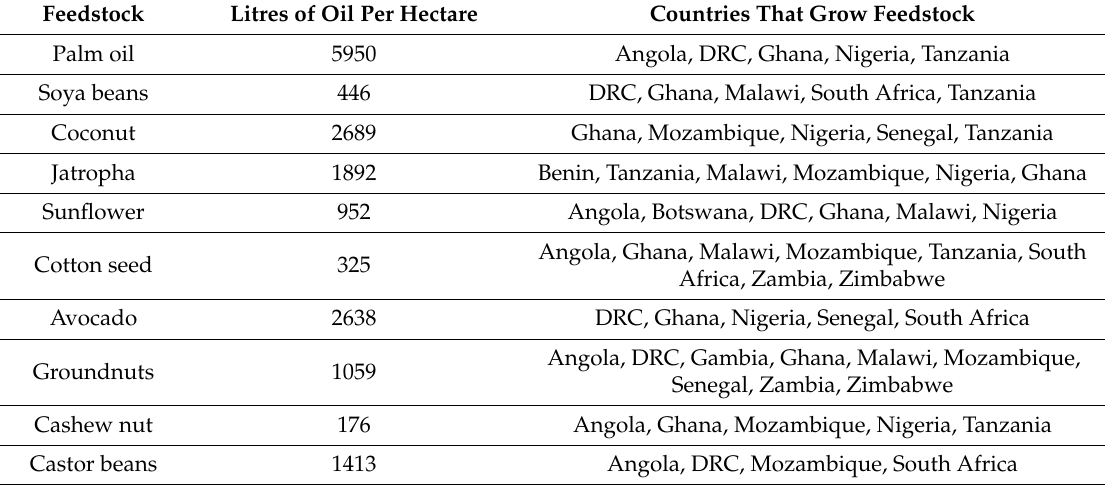
Table 2. Oil yields from various feedstocks across Africa [10,23]. Feedstock Litres of Oil Per Hectare Countries That Grow